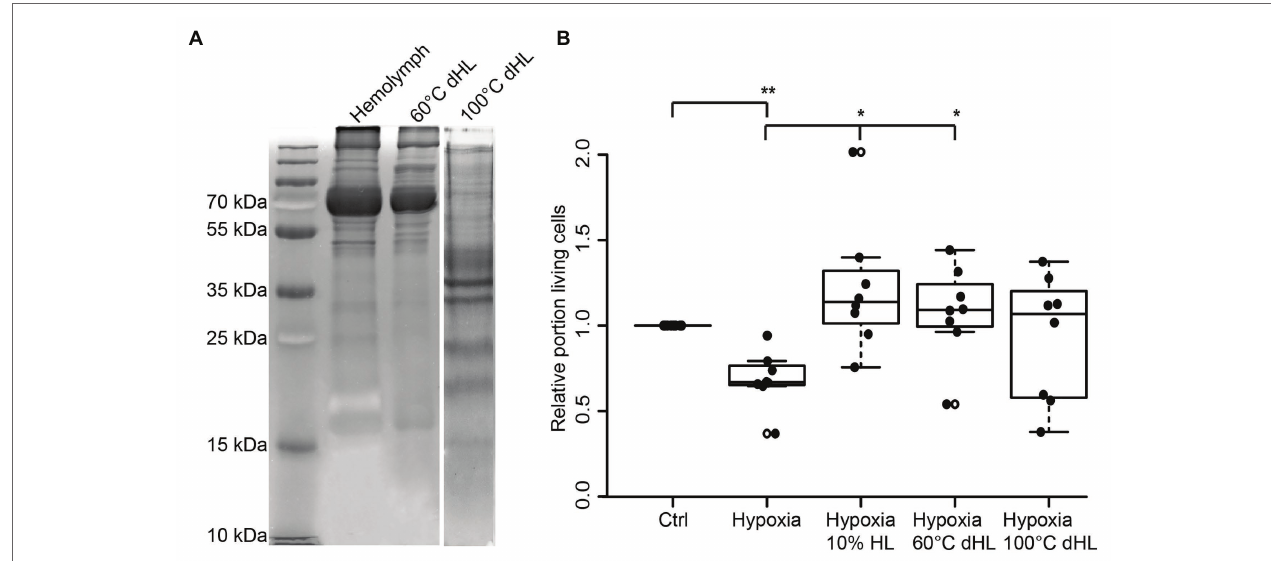
FIGURE 4 | Effects of heat-denatured locust hemolymph (dHL) on relative survival of hypoxia-exposed locust neurons in vitro . (A) Ten percent sodium dodecyl sulfate–polyacrylamide gel electrophoresis (SDS PAGE) was loaded with 50 μ g protein of HL, HL denatured at 60 ° C and HL denatured at 100 ° C. HL denatured at 60 ° C shows similar patterns of separated proteins compared to control HL. In contrast, larger proteins ( ≥ 50 kDa) are absent in HL denatured at 100 ° C. Intense staining of proteins between 30 and 50 kDa (including two clear bands at around 35 kDa) might result from higher concentrations of smaller proteins in the applied sample (50 μ g total protein) due to previous removal of heat-denatured proteins. Hundred degrees Celsius dHL proteins show no intense protein bands above 35/40 kDa. (B) Locust neurons were treated with either basal L15 medium, 10% HL, 10% 60 ° C dHL, or 100 ° C dHL during hypoxia-exposure. Hypoxia significantly decreased relative neuron survival compared to normoxic control. Hypoxia-induced apoptosis was prevented by 10% HL and 10% HL denatured at 60 ° C. Neuron survival in cultures supplemented with HL denatured at 100 ° C was not significantly different to normoxic control or hypoxic control cultures. n = 8; Total cells evaluated: 160,595. Pairwise permutation test with Benjamini Hochberg correction. * p < 0.05; ** p <